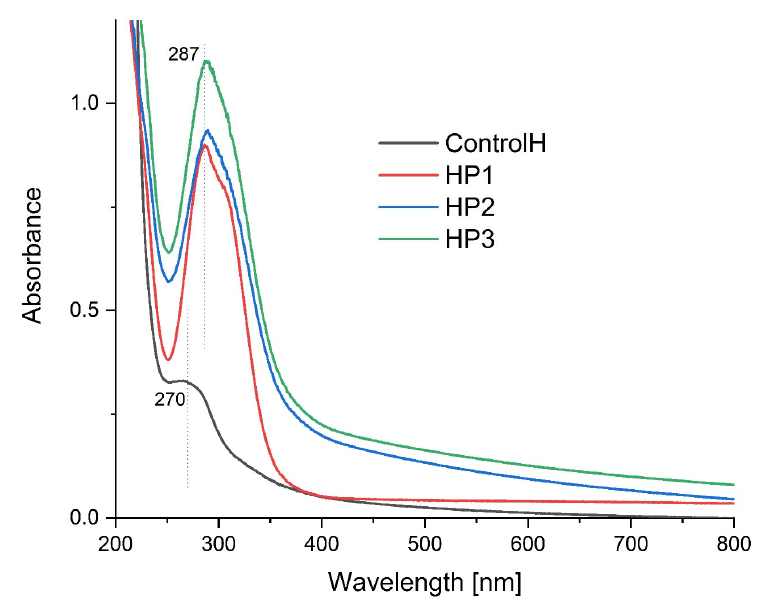
Figure 2. UV-Vis spectrum for the obtained Figure 2. UV ‐ Vis spectrum for the obtained films.